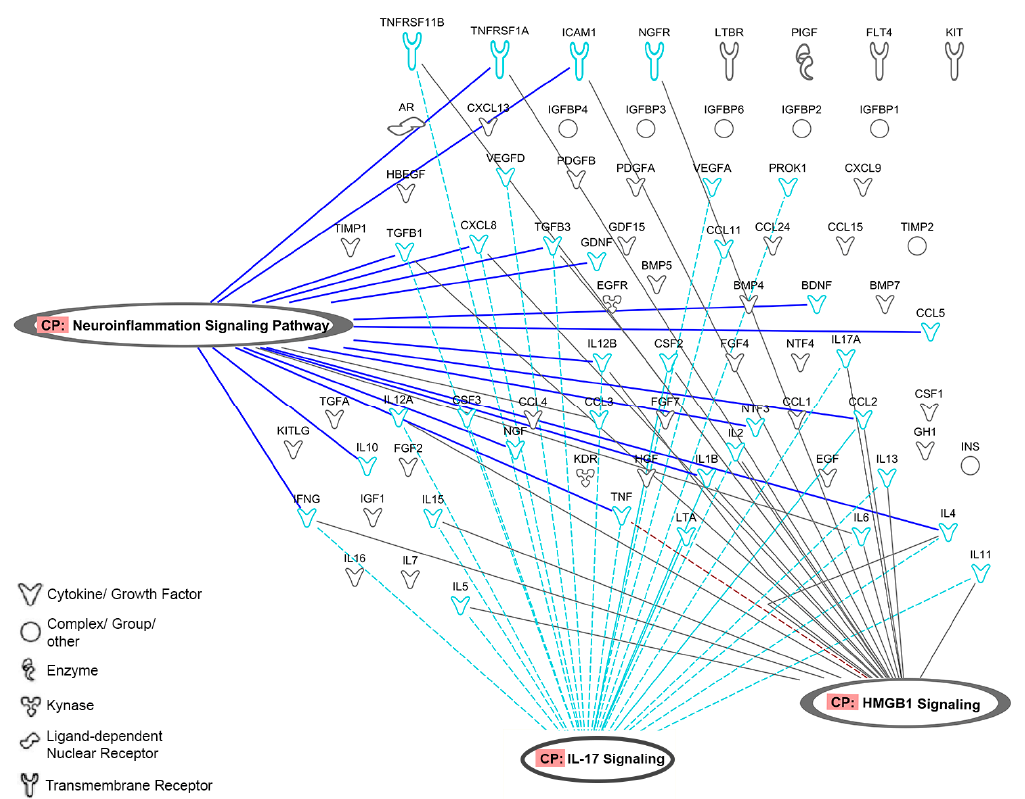
Figure 4. Representation of proteins involved in neuroinflammation signaling pathways and their connections with IL-17 and HMGB1 signaling (figure was created using Ingenuity Pathway Analysis (IPA), QIAGEN).